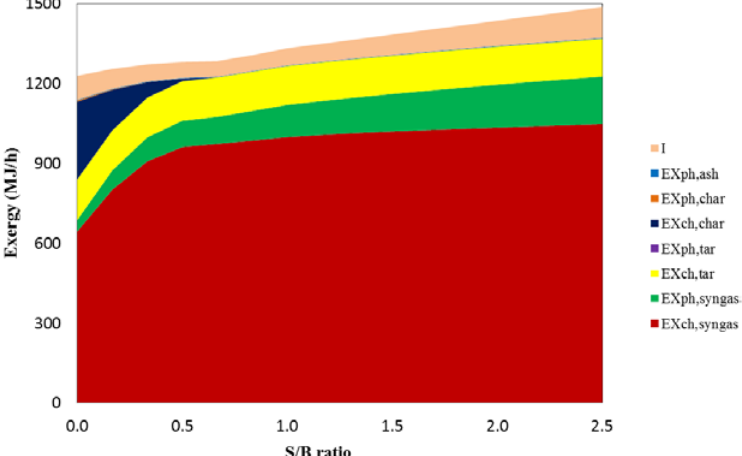
Figure 4. Exergy balance of the HTAG process as a function of S/B ratio for T = 1000 °C.